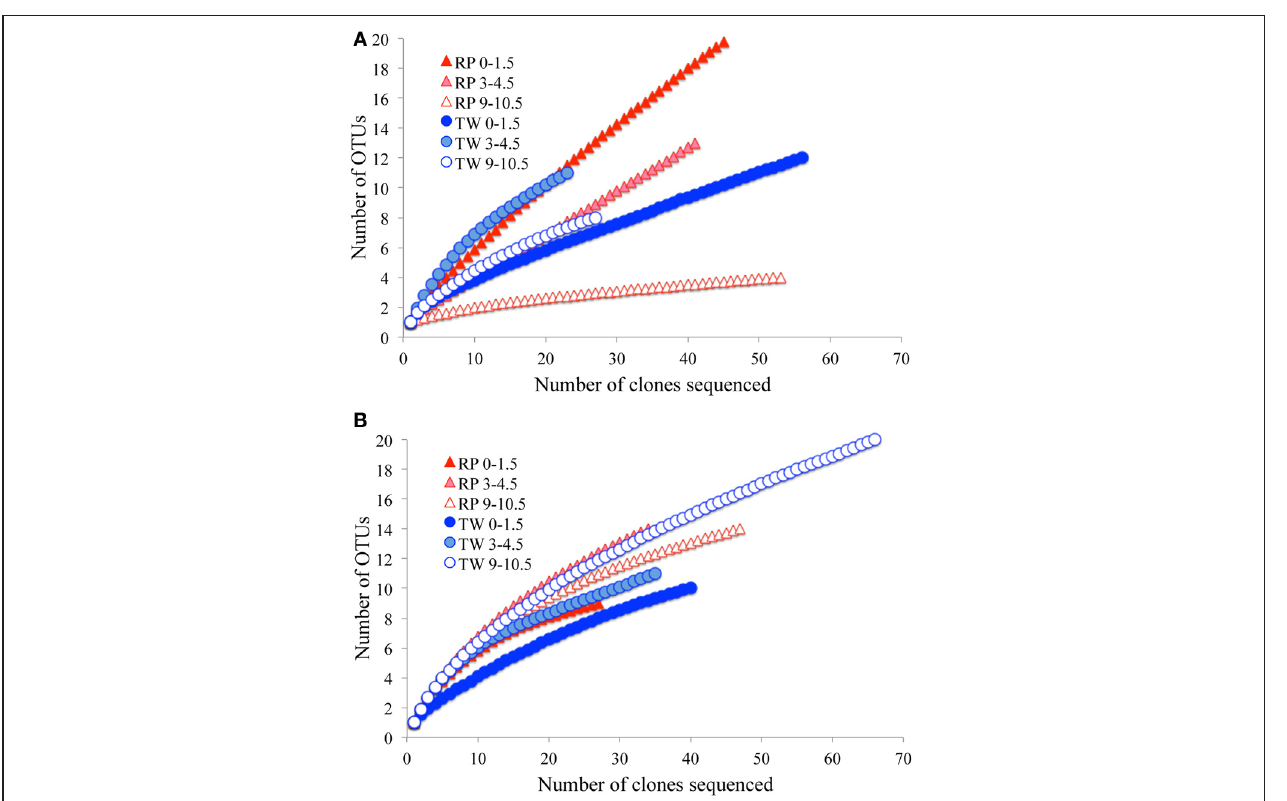
FIGURE A1 | Rarefaction curves showing 16S rRNA OTU richness for each of the sampling sites and depths for this study. Curves were calculated using the furthest neighbor approach with a 97% sequence similarity cutoff. Data shown are for Bacteria (A) and Archaea (B) .